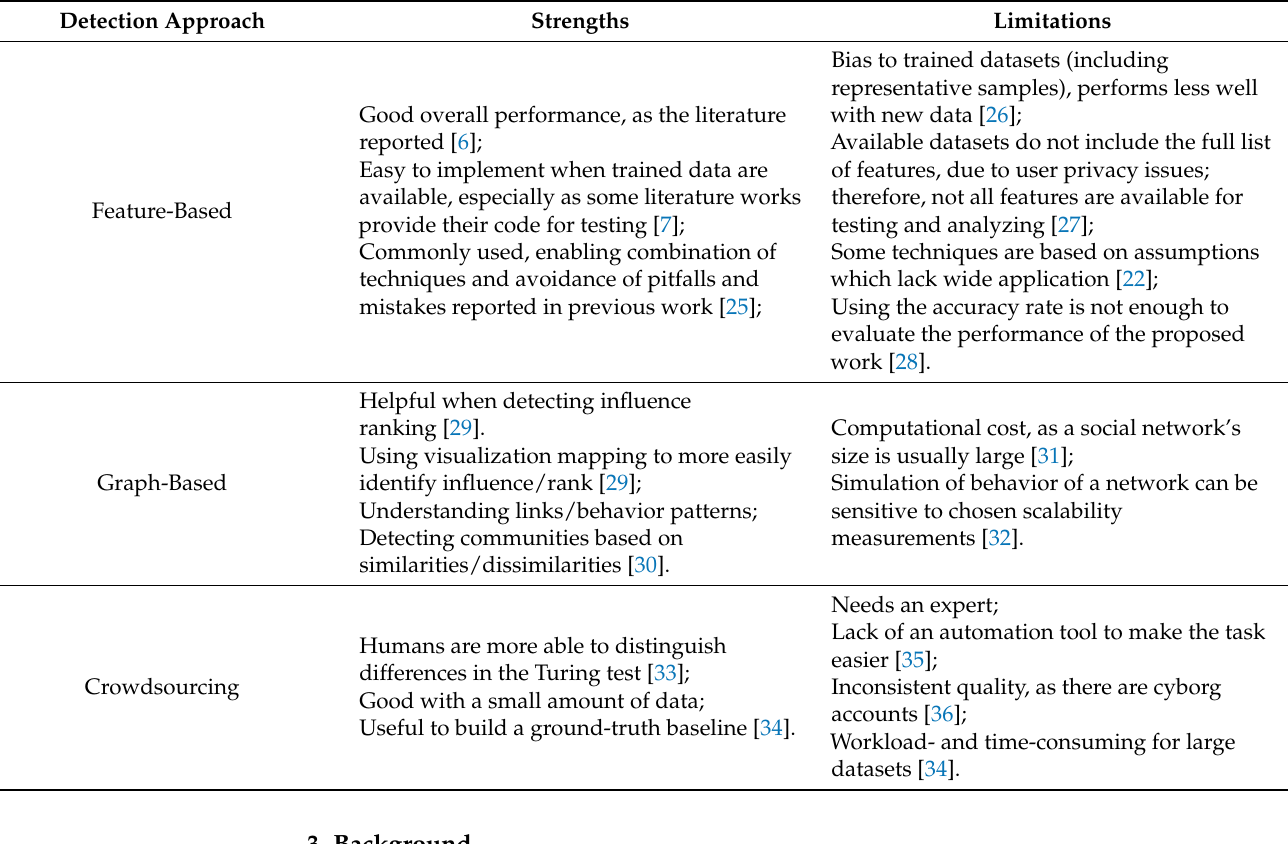
Table 1. Supervised learning approaches’ strengths and